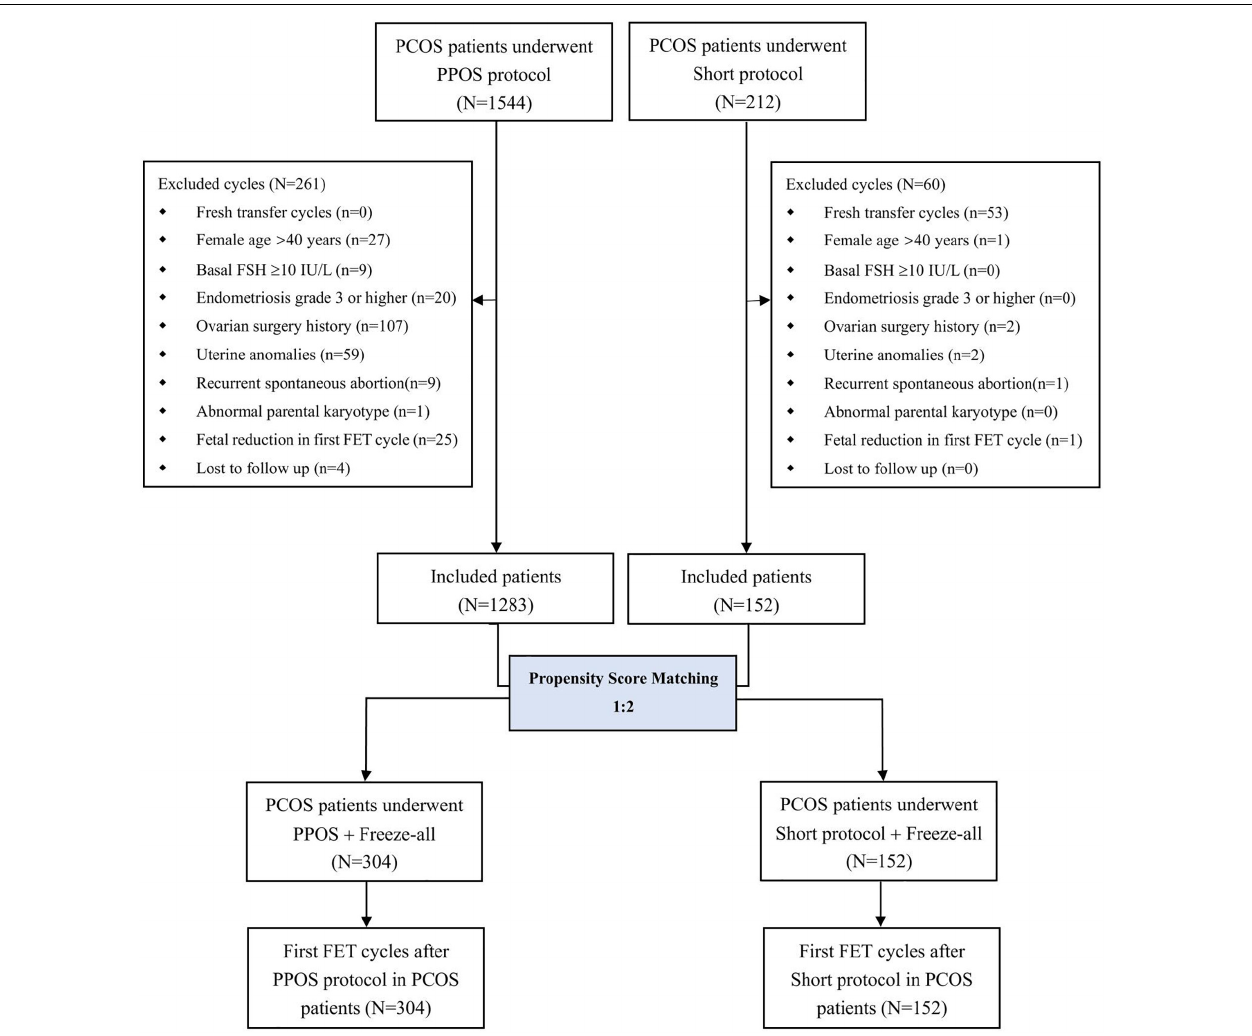
FIGURE 1 | Flow chart of the current study. PCOS, polycystic ovary syndrome; PPOS, progestin-primed ovarian stimulation; FSH, follicle-stimulating hormone; FET, frozen-thawed embryo